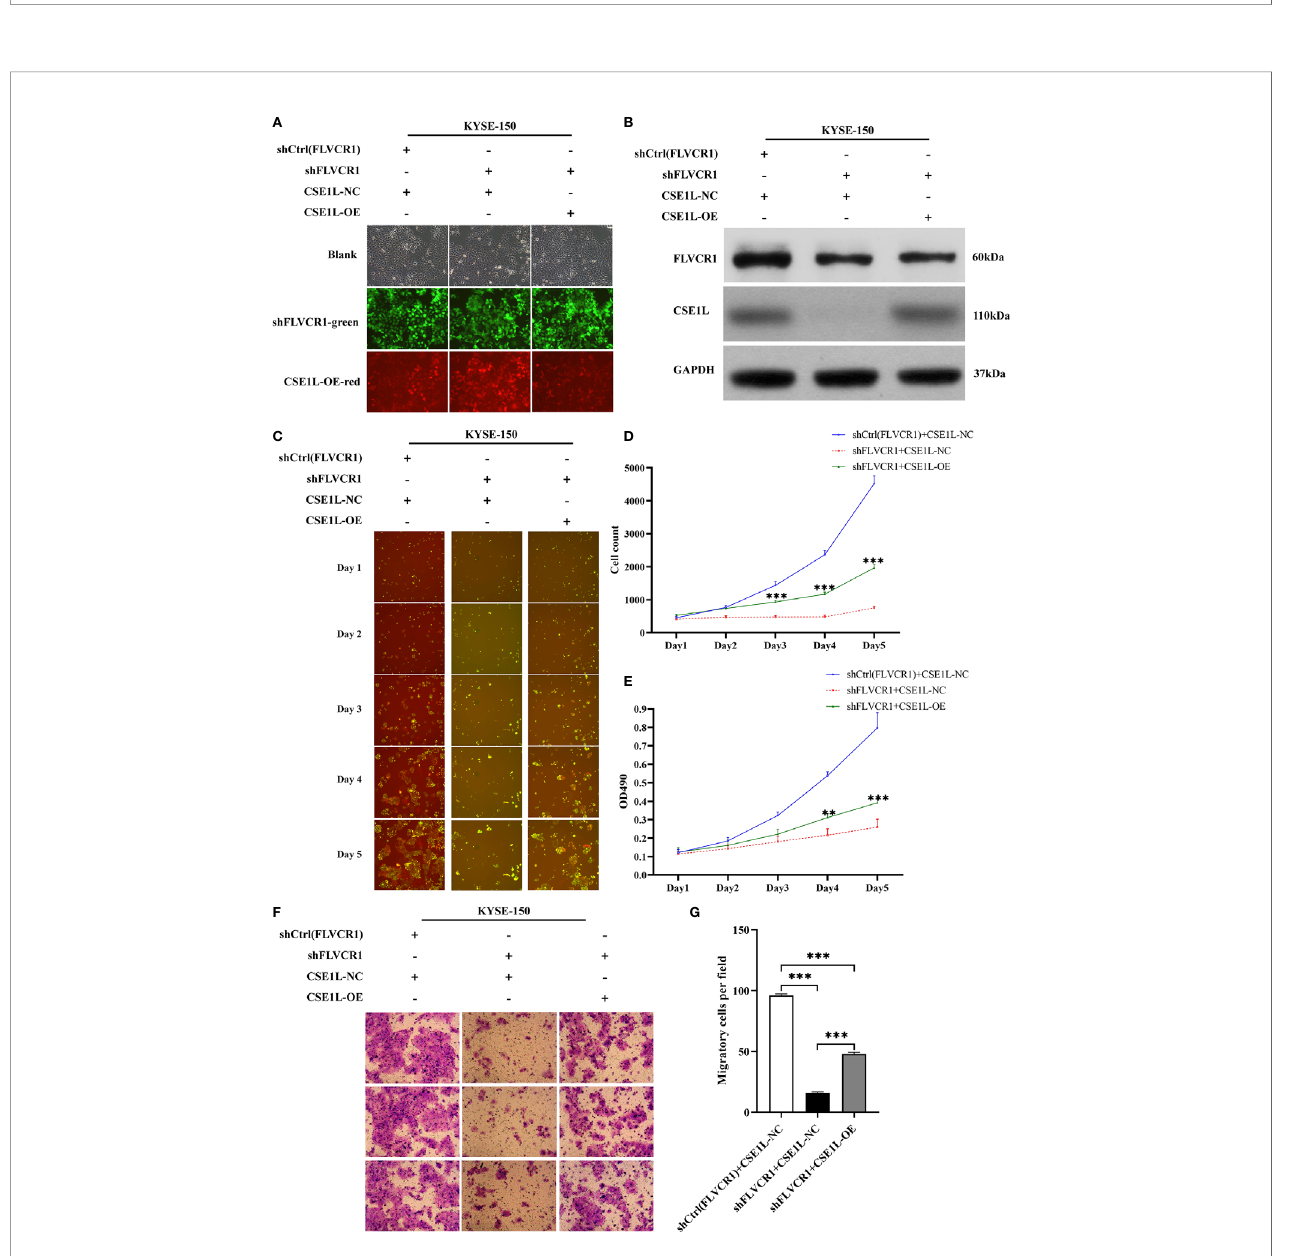
FIGURE 7 | CSE1L re-expression partly counteracted the negative effect of FLVCR1 inhibition on the proliferation and migration of KYSE-150 cells. (A) KYSE-150 cells expressed green and red fl uorescence after successful infection. Magni fi cation 100×. (B) , Western blot analysis showed that the expression of CSE1L was restored in the shFLVCR1+CSE1L-OE group and downregulated in the ShFLVCR1+CSE1L-NC group. (C – E) Re-expressed CSE1L partially diminished the proliferation inhibitory effect of FLVCR1 knockdown compared to shFLVCR1+CSE1L-NC group. (F, G) Compared to the shFLVCR1+CSE1L-NC group, the migration ability was restored by ectopic expression of CSE1L. Data were represented as the mean ± SD. **P < 0.01, ***P <